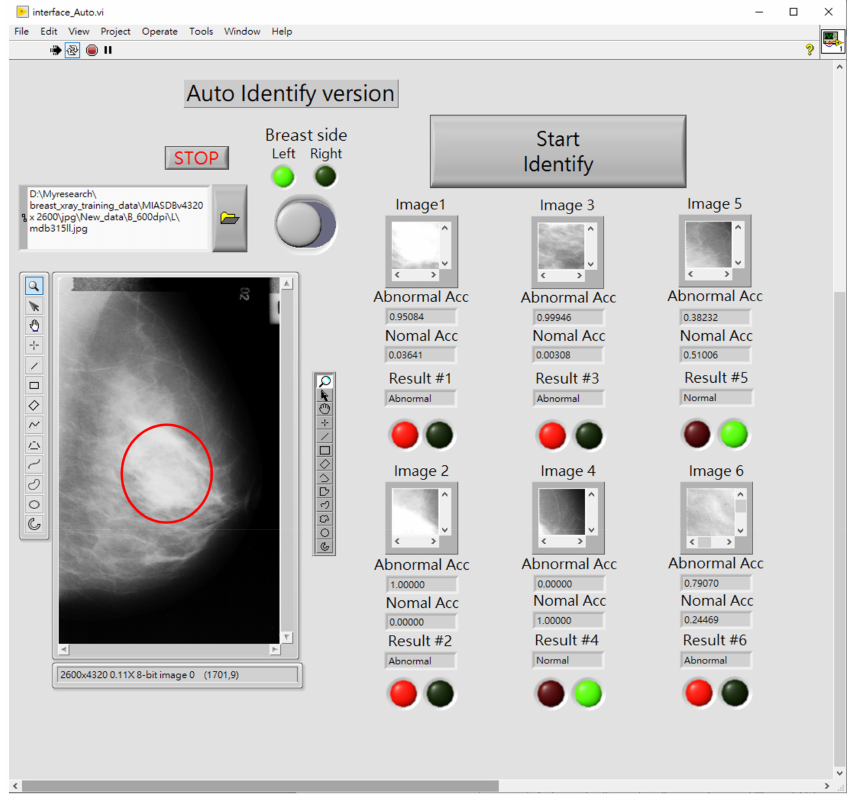
Figure 8. Human–machine interface of the computer assistive system and its automatic screening